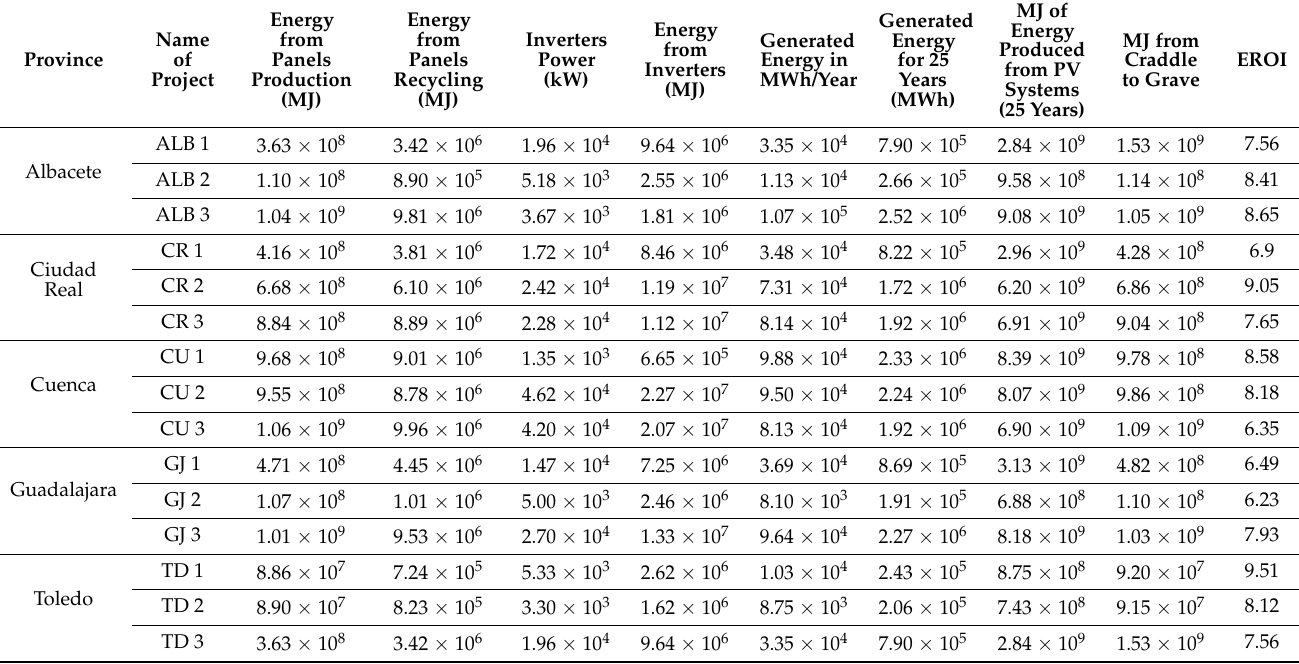
Table A3. Calculation of the Energy Return of Investment for the 15 selected PV power plants in Castilla-La